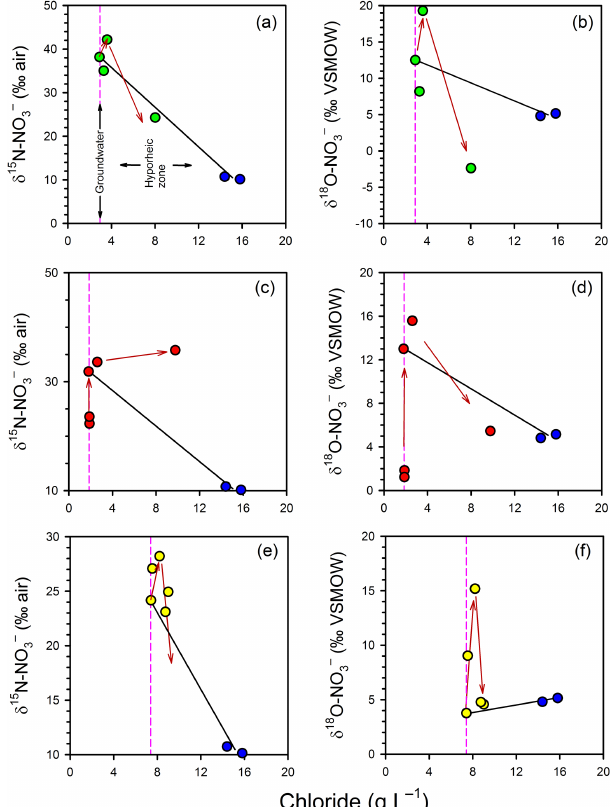
Figure 5. Evaluation of mixing and transformations for NH + e) and NO − (b, d, f) for Profile 1 (a, b) , Profile 2 (c, d) and Profile 3 3 (e, f) . The vertical pink lines represent samples collected in the groundwater zone and those to the right of this line are within the hyporheic zone, based on chloride concentrations. The blue circles represent the surface water samples. The black solid lines represent the expected N concentrations in the hyporheic zone if only conser- vative mixing occurred. The black dashed lines evaluate whether N was consumed or produced in the hyporheic zone (see Fig. 3).